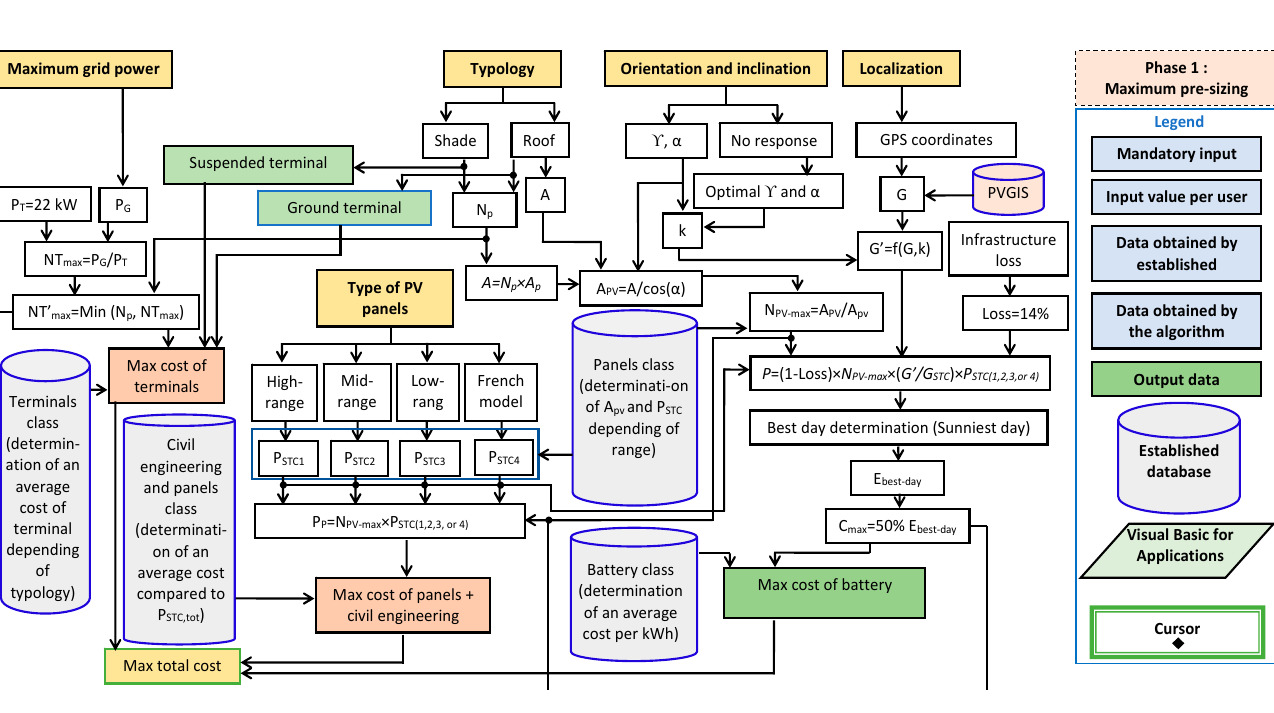
Figure 1. Flow chart of phase 1.